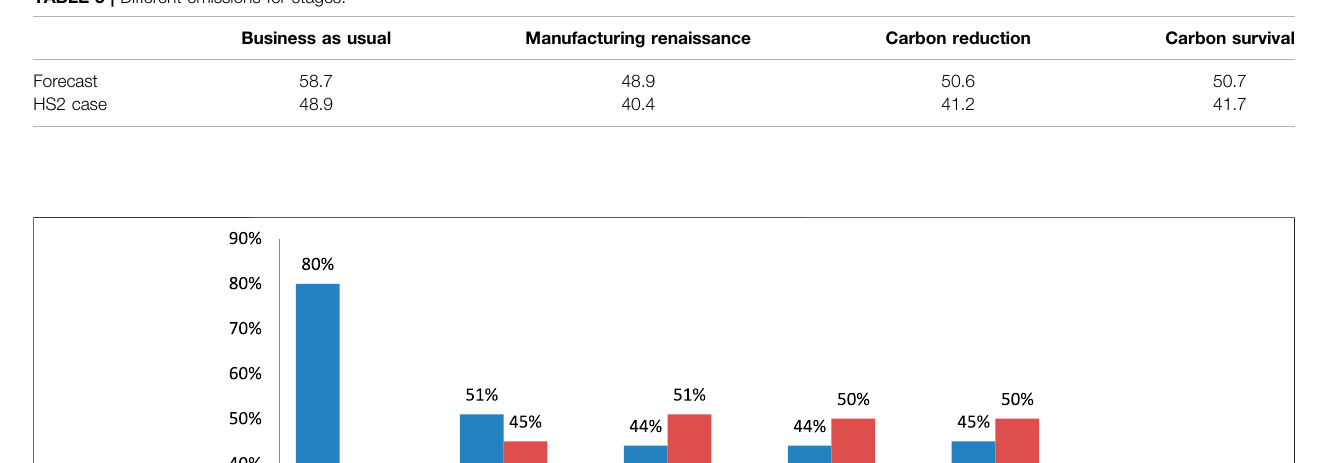
TABLE 5 | Different emissions for stages.